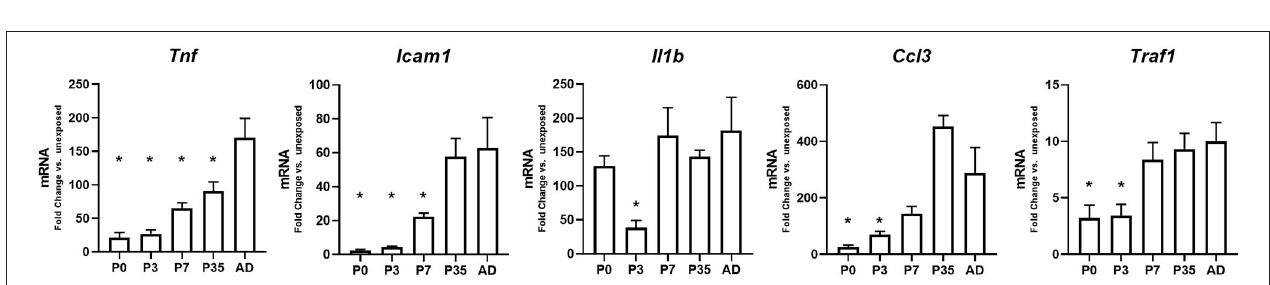
FIGURE 4 | IP LPS induces age-specific hepatic NF- κ B activation. Representative EMSA of hepatic nuclear extracts from p7 and adult mice exposed to IP LPS (5mg/Kg, 1h) and control (CTR) (A–C) . Bands represent NF- κ B consensus sequence binding, non-specific binding, free probe, and supershift (black arrows) are labeled. Superscript letters indicate different antibodies used: A p50 (1.06mg/mL, ab32360, Abcam, Cambridge, MA, USA), B p65 (201 µ g/mL, #8242, Cell Signaling, Danvers, MA, USA), C p50 (170 µ g/mL, #13586, Cell Signaling, Danvers, MA, USA), and D p50 (1mg/mL, #90275, Millipore, Burlington, MA, USA).